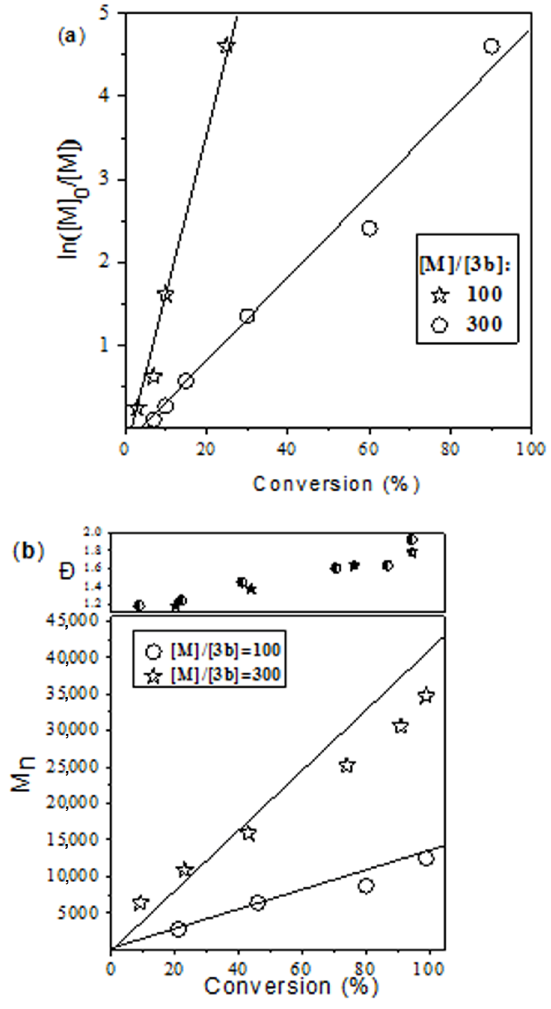
Figure 6. ( a ) ln[ M ] 0 /[ M ] vs. time; ( b ) M n , Ð vs. conversion dependences for the bulk D , L -lactide polymerization for complex 3b at 130 ◦ C and at different [ M ]/[catalyst] ratios. The straight lines in Figure 6b correspond to the theoretical molecular weight calculated as M n (theor) = ([ D , L -lactide]/[catalyst]) × 144 × Conversion + 115. Experimental values of the molecular weight determined by SEC vs. polystyrene standards were corrected by a factor of 0.58 [85] . It should be noted that for poly( D , L -lactide)s synthesized with 3b and 3c , similar